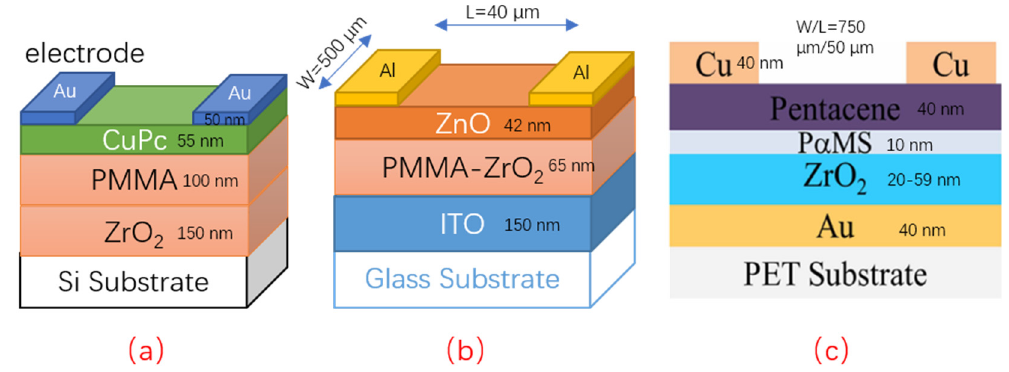
Figure 7. ( a ) Schematic structure and dimensions of the Organic Field Effect Transistors (OFET) with the PMMA/ZrO 2 bilayer as dielectrics [68]; ( b ) Schematic structure and dimensions of the metal oxide thin film transistor (MOTFT) with a ZnO semiconductor layer and PMMA − ZrO 2 hybrid films as gate dielectric [69]; ( c ) Schematic structure and dimensions of the organic thin film transistor (OTFT) with the P α MS/ZrO 2 bilayer as dielectrics